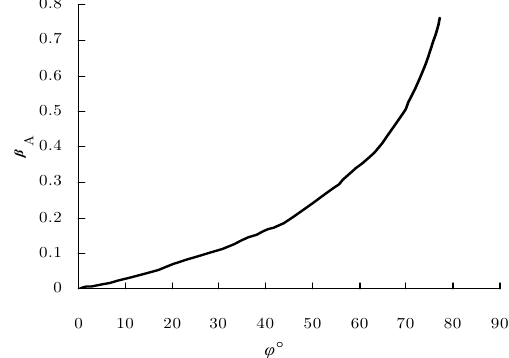
Fig. 2. β A values as a function of the angle of obliqueness ( ϕ ◦ ) (Bos,